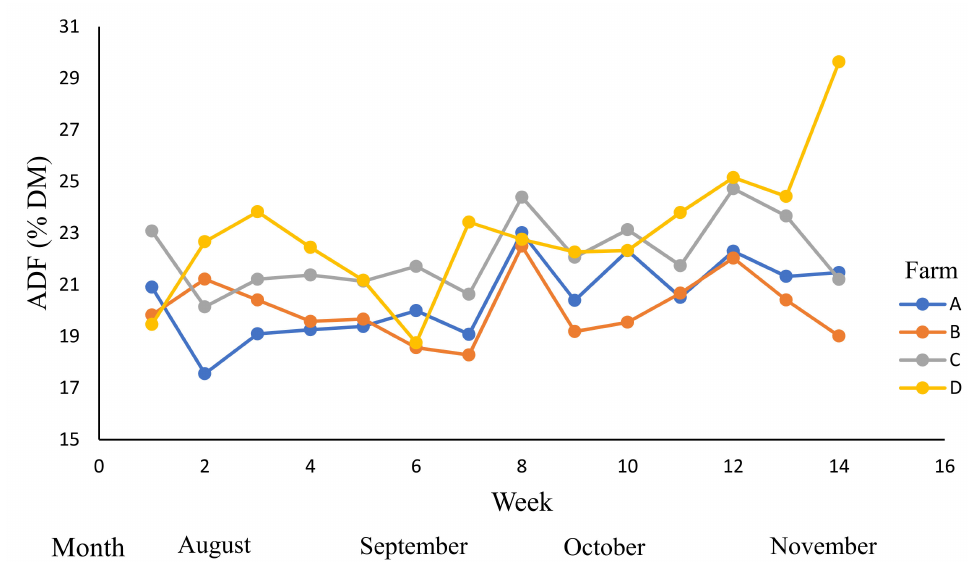
Figure 4. The variations in the acid detergent fibre (ADF) content (% dry matter (DM) across dairy farms (A–D) during winter and spring; 0–14 weeks (August to November 2019).